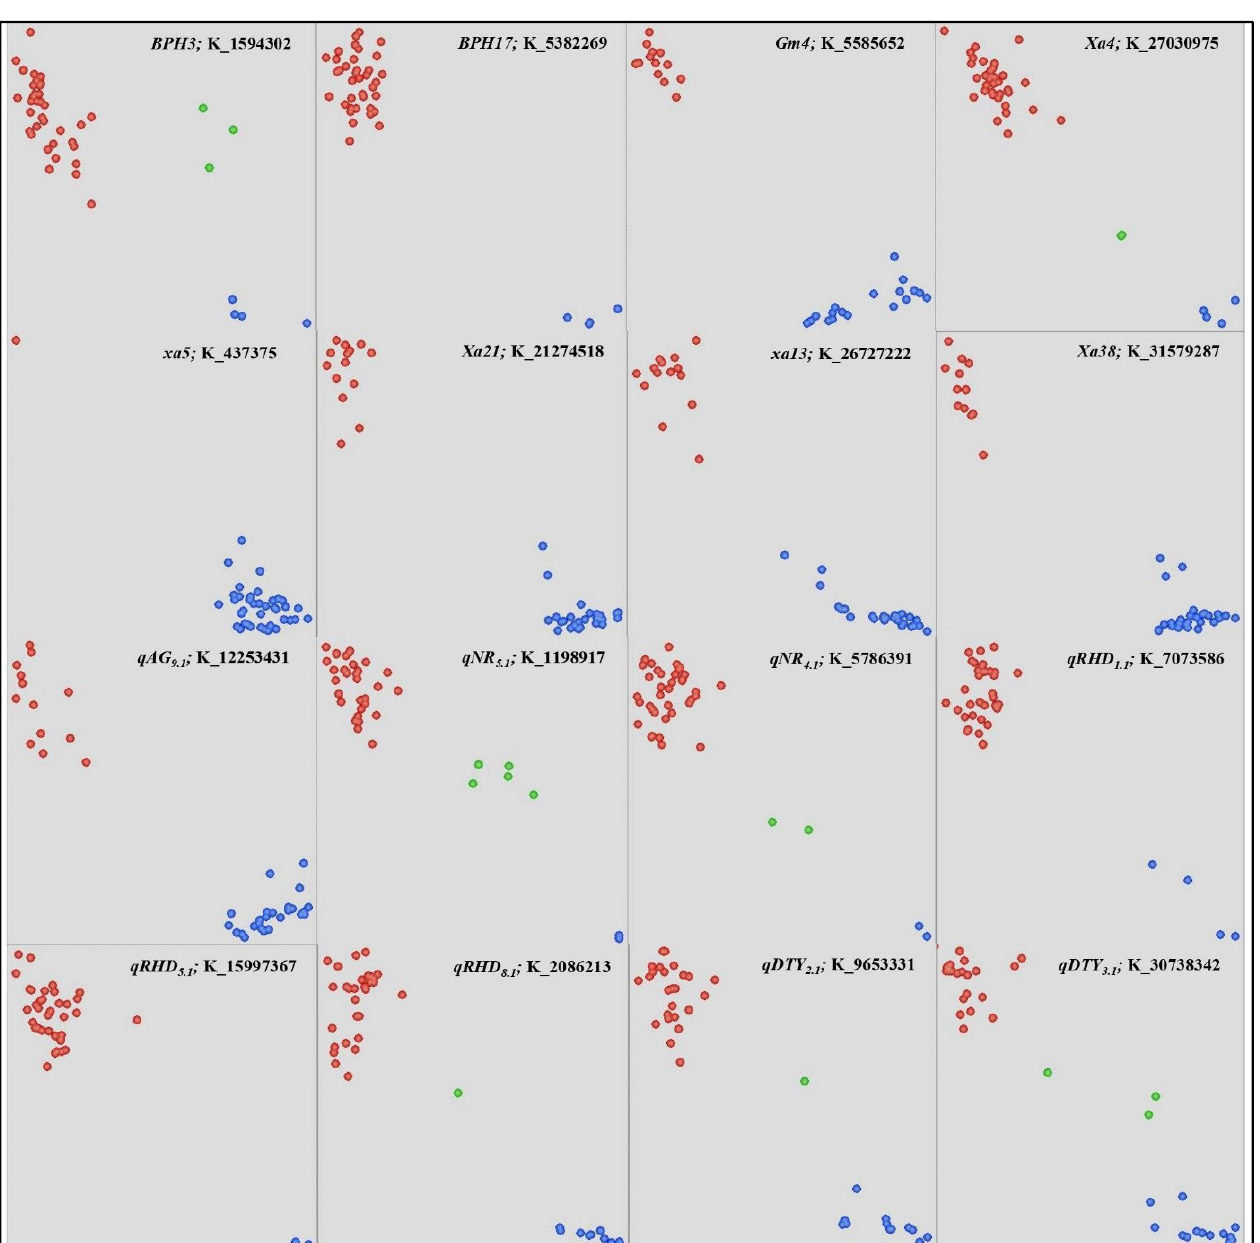
Figure 2. The pictorial representation of the KASP assay conducted on the advanced breeding lines panel including 13 DSR adapted donor checks, 2 control checks, and 27 advanced breeding lines. The blue color indicates the donor allele, the red color indicates the alternate allele, and green color indicates the heterozygotes.